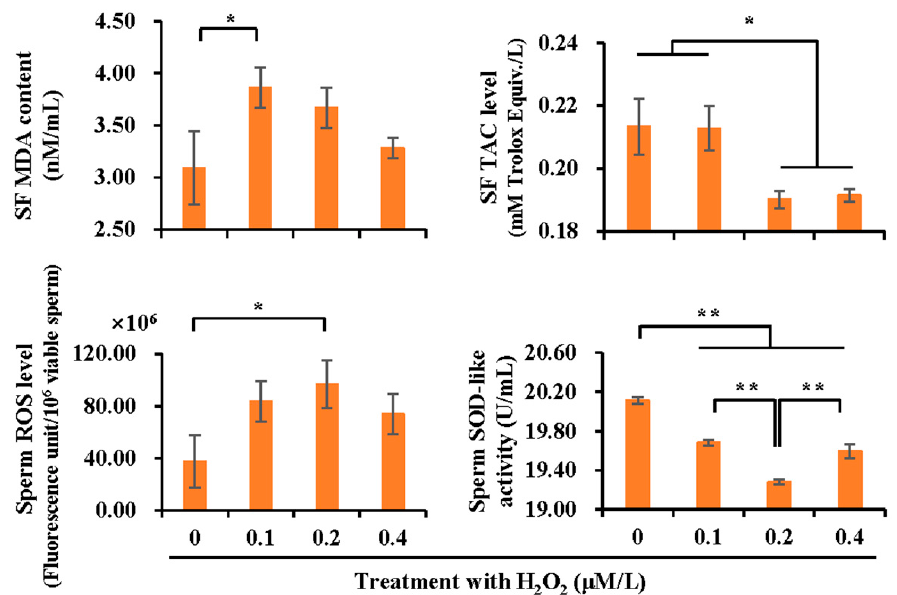
Figure 5. The effect of H 2 O 2 treatment (0, 0.1, 0.2 and 0.4 µ M/L) on antioxidant and oxidant levels in boar spermatozoa and SF. MDA: malondialchehyche, ROS: reactive oxygen species, TAC: total antioxidant capacity, SOD: superoxide dismutase. Bar graphs stand for data expressed as mean ± SEM. * indicates differences among groups, p < 0.05; **, p < 0.01.